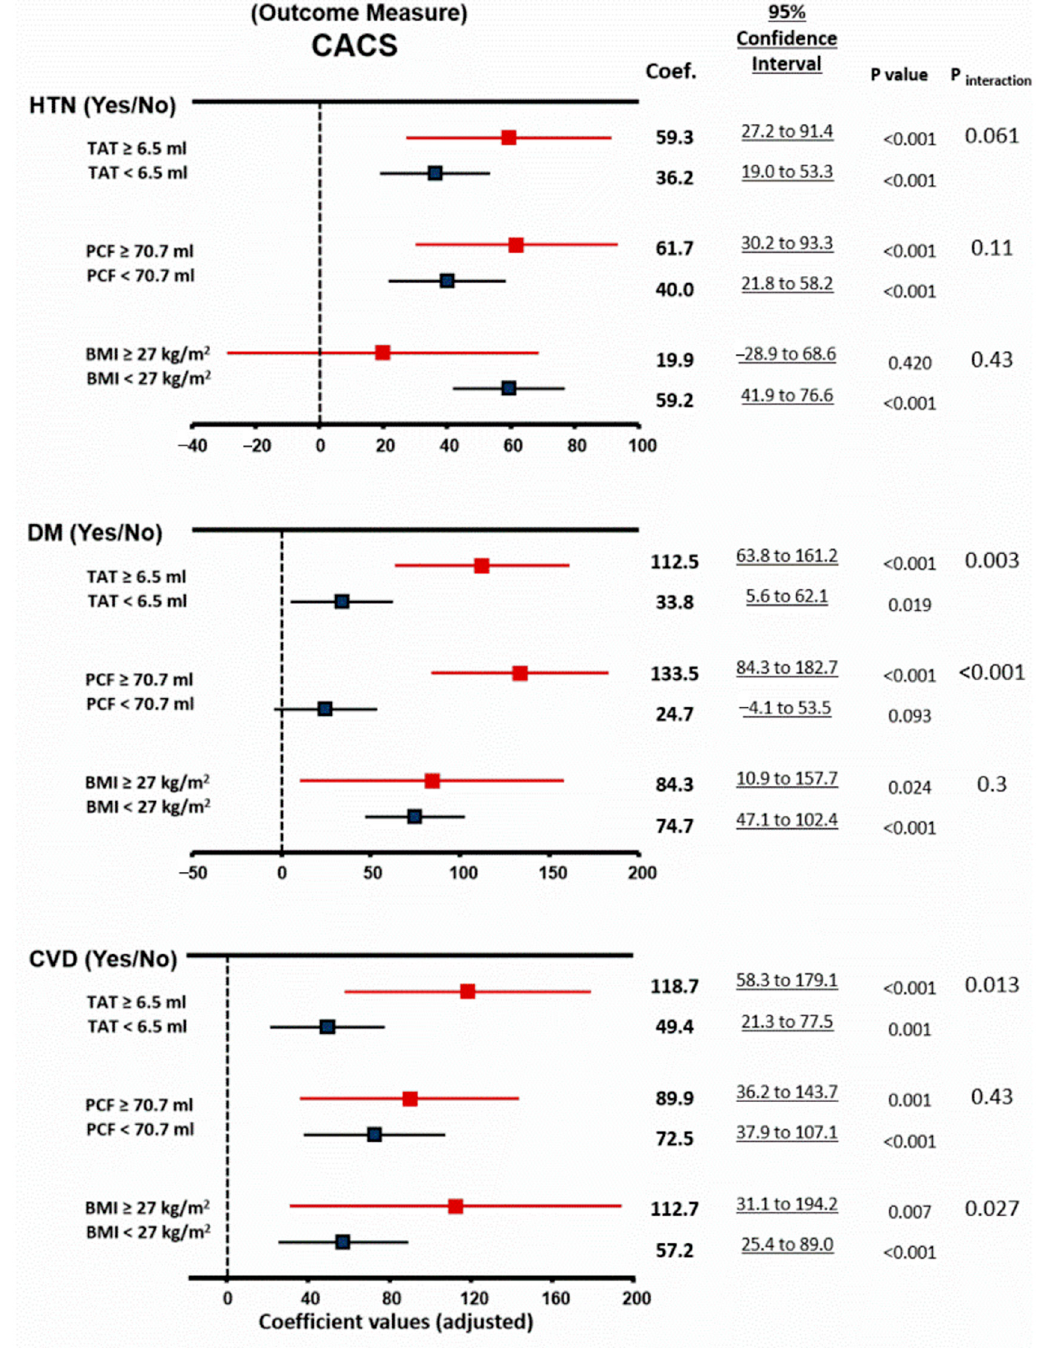
Figure 3. Associations of coronary artery calcification scores (CACS) with physical obesity from Table